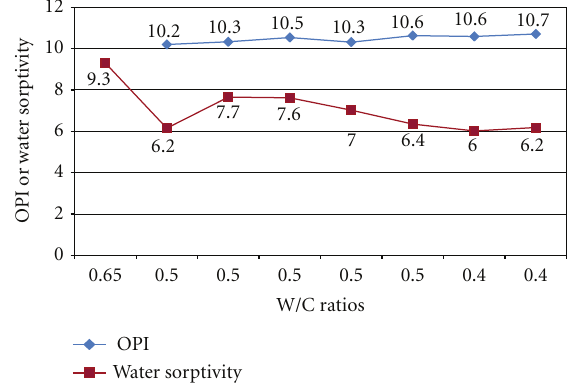
Figure 3: OPI and water sorptivity results for CEM II/A-V 52.5N at di ff erent w/c ratios.